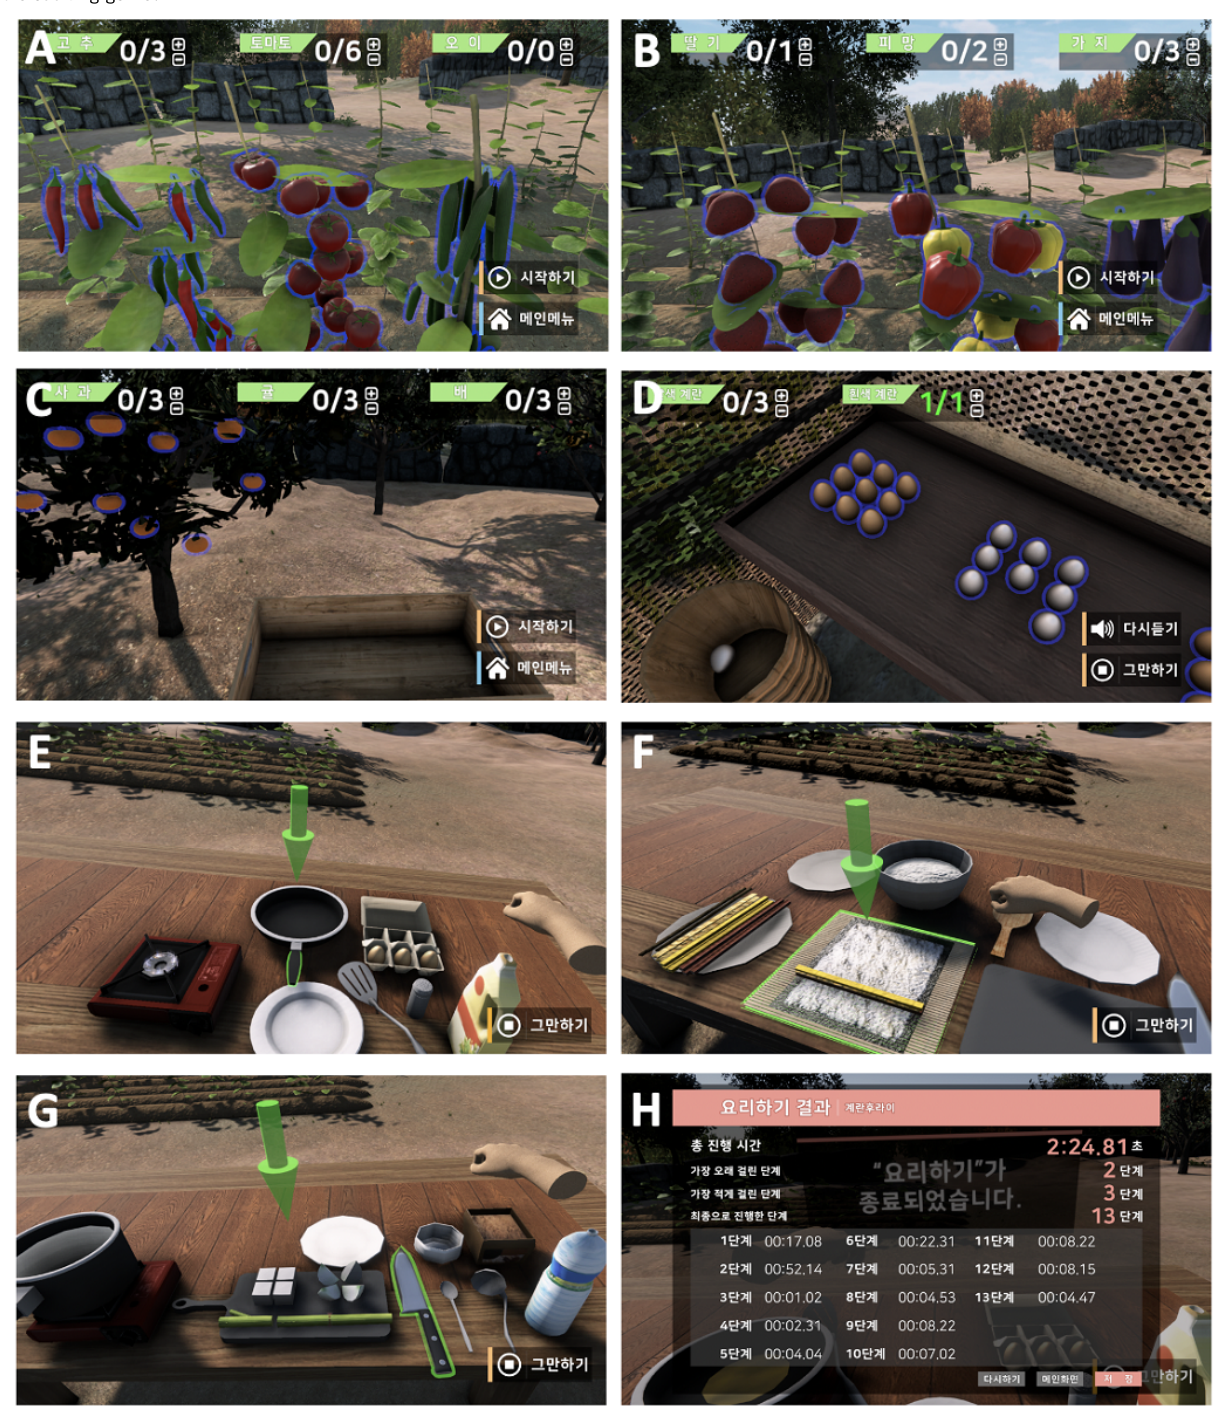
Figure 3. Harvest and cook game: (A) farm A (chilis, tomatoes, and cucumbers), (B) farm B (strawberries, paprika, and eggplants), (C) orchard (apples, mandarins, and pears), (D) hen house (brown eggs and white eggs), (E) fried eggs, (F) gimbap (dried seaweed roll), (G) soybean paste stew, (H) results of the cooking